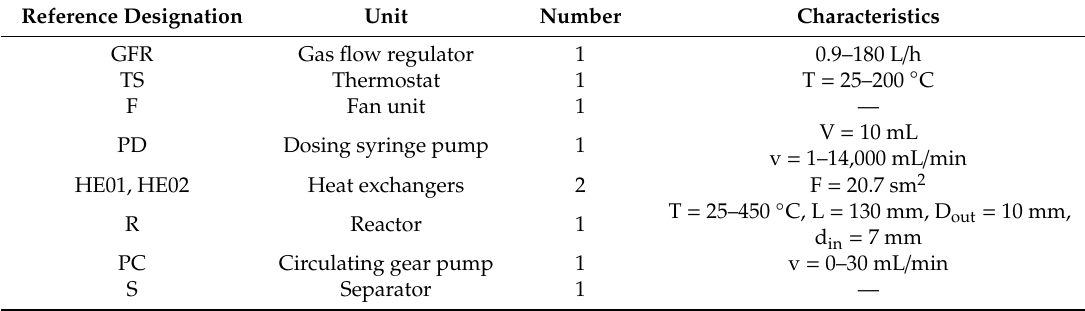
Table 1. Composition and characteristics of the components of the facility for thermolysis.